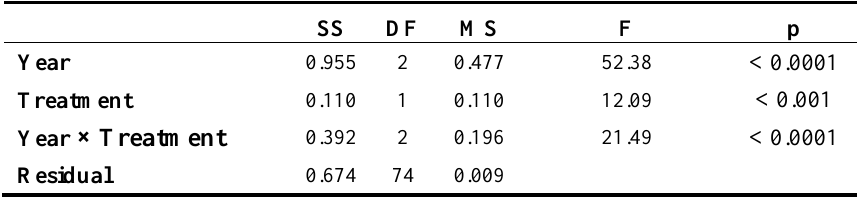
Table A1.4. Two-way ANOVA of turf length bioassay data, comparing lengths of algal turfs on EAM covered rocks moved from the reef flat to the crest (treatment) with controls moved and replaced on the flat. pooling site where it was found to have no effect (sites pooled as no significant difference was found, data Log10(n+1) transformed to meet assumptions of the